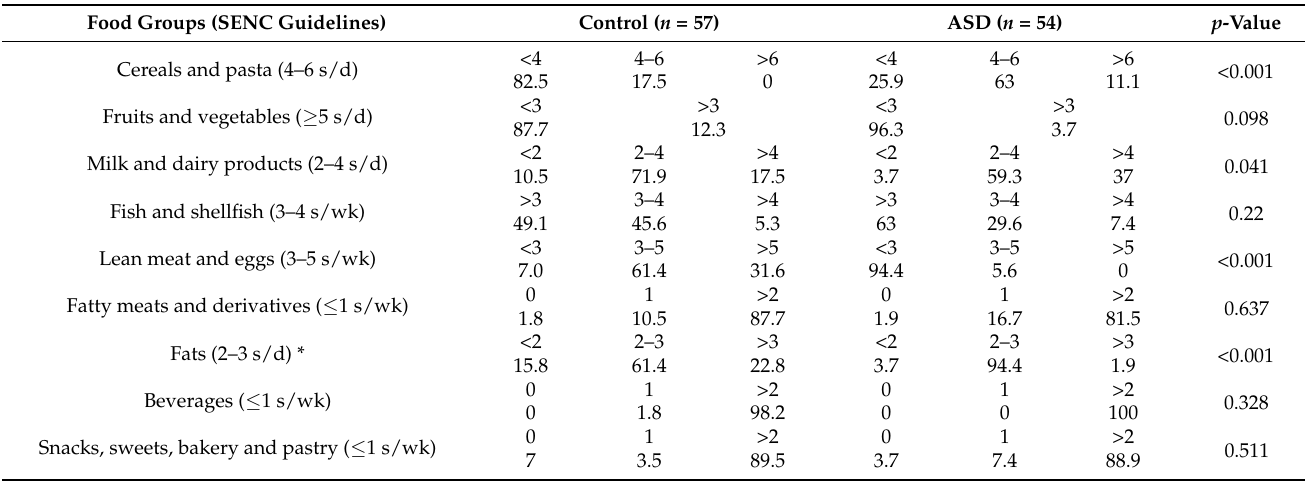
Table 3. Percentage of food group consumption (in servings per day or week) according to food frequency questionnaires and adequacy to the Spanish Society of Community Nutrition (SENC) dietary guidelines of preschool children with ASD compared with a healthy control